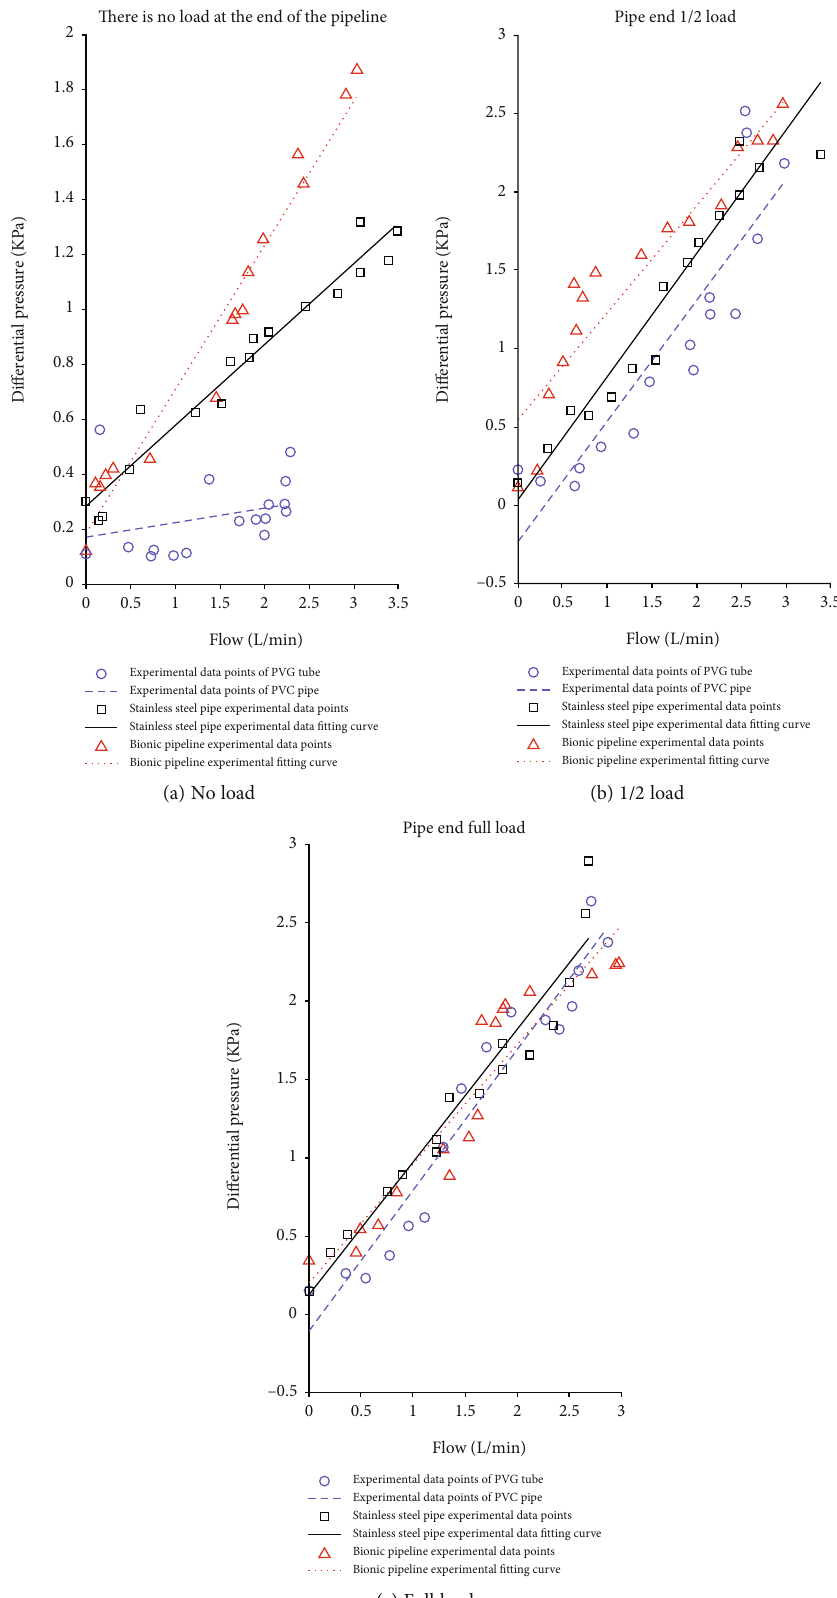
Figure 12: Infusion liquid-glycerol